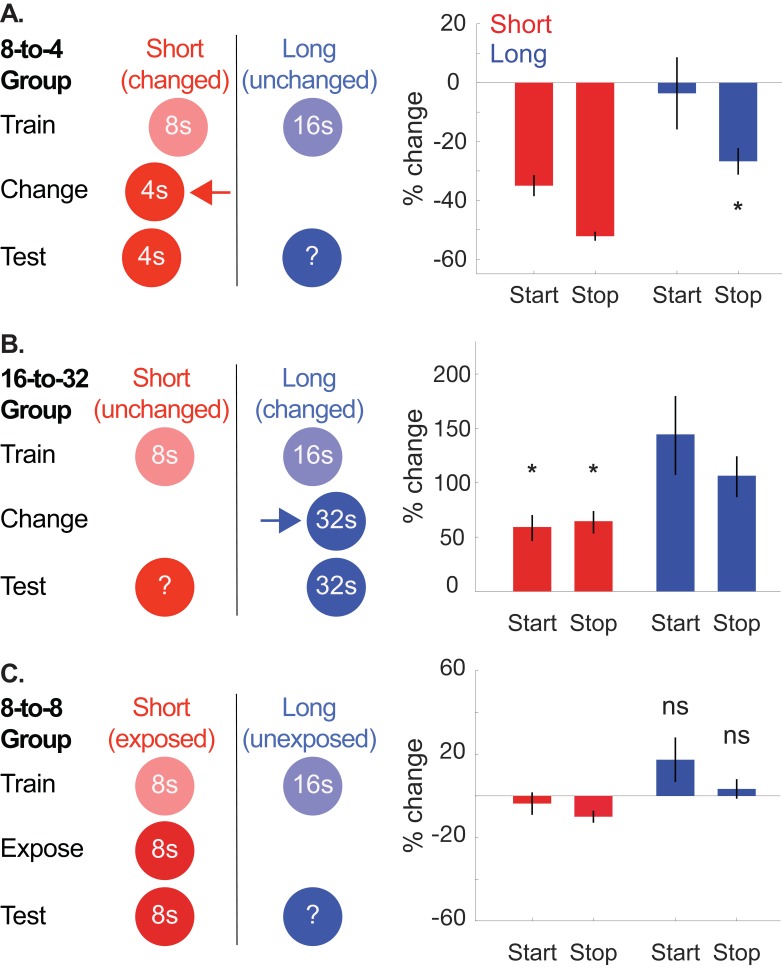
A and B depict design schematics (left panels) and average percent change in start/stop times (±SEM; right panels) for the 8-to-4 and 16-to-32 groups for Experiment 1, respectively.(C) shows the same for the no-change control group.10.7554/eLife.38790.006Figure 1—figure supplement 2—source data 1.Data used to generate Figure 1—figure supplement 2.